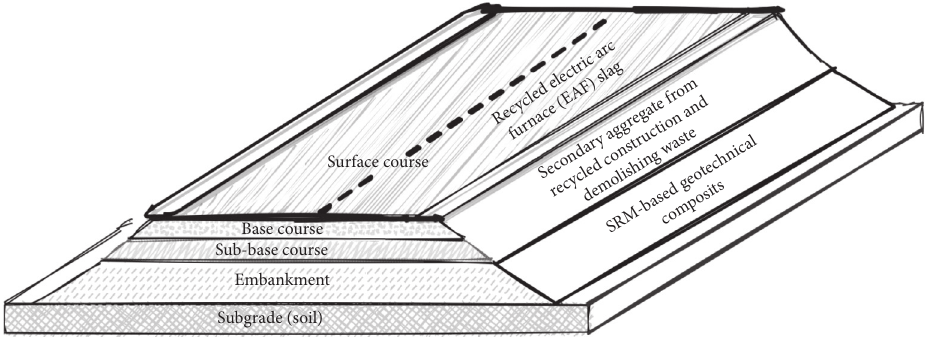
Figure 1: Typical road layers and type of SRM